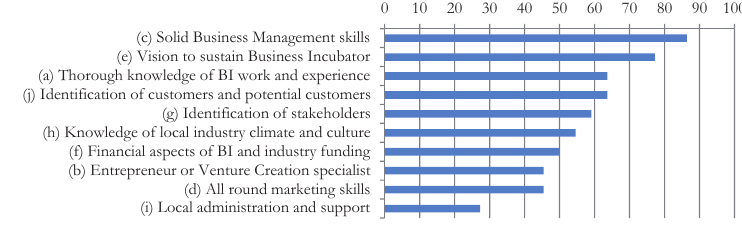
Fig. 2 – BI Managers perception of skills set required. Source: authors